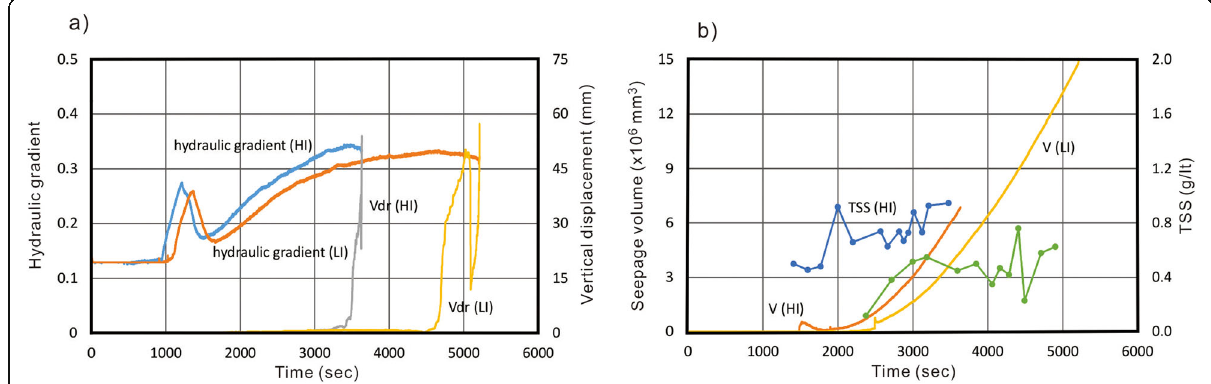
Fig. 5 Time series data of hydraulic gradient, vertical displacement, seepage volume and TSS for the sample S4568 at a low inflow rate (LI) of 1.1 × 10 − 5 m 3 /s and high inflow rate (HI) 1.67 × 10 − 5 m 3 /s. a Hydraulic gradient and vertical displacement; b Seepage volume and TSS